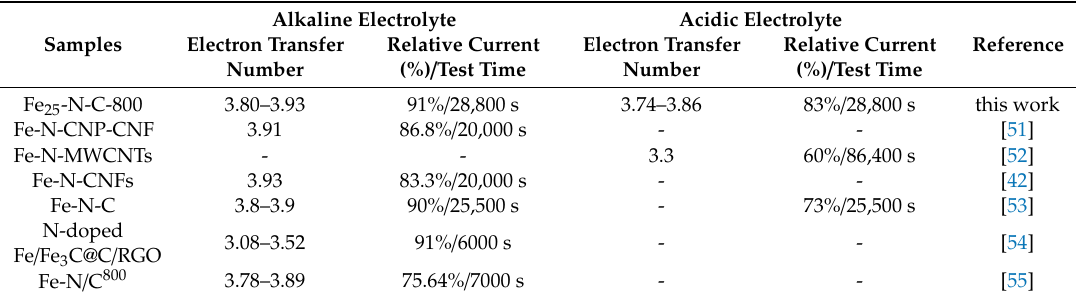
Table 3. Electrochemical performance of di ff erent electrocatalysts for